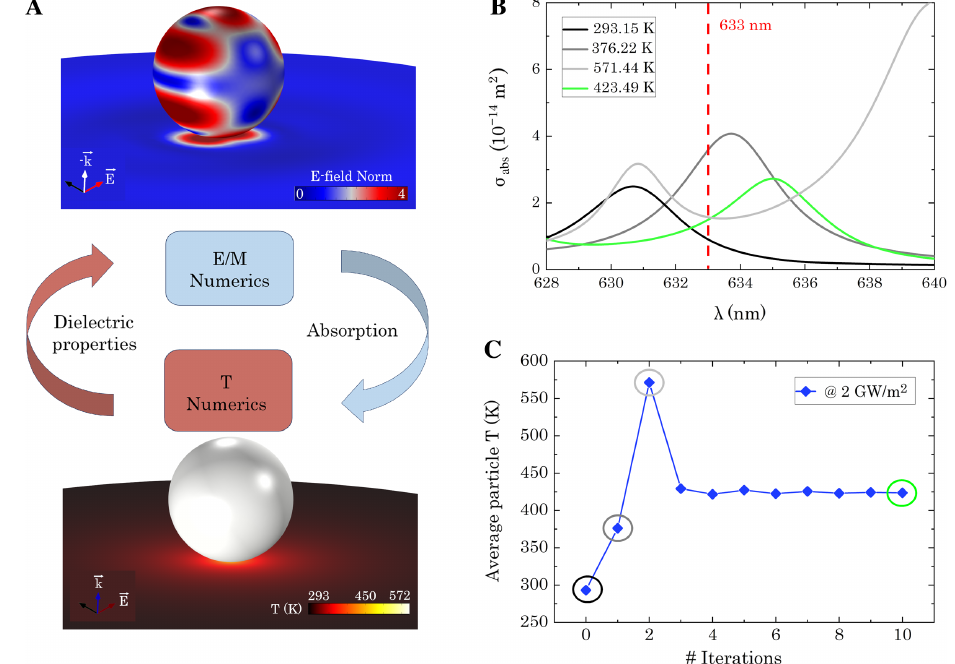
Figure 5: Recursive numerical modeling of self-induced optical heating. (A) Schematic illustration of the recursive numerical calculation that continuously iterates between electromagnetic and thermal calculations, updating the absorbed power and dielectric properties accordingly. (B) Absorption cross-section spectrum of a Si nanosphere of 350-nm diameter on a fused silica substrate as a function of temperature for different steps of the iterative procedure. The black line represents the initial situation at room temperature, whereas the green line is the spectrum at equilibrium. The red line is the chosen illumination wavelength. (C) Average temperature of the nanosphere as a function of the iteration